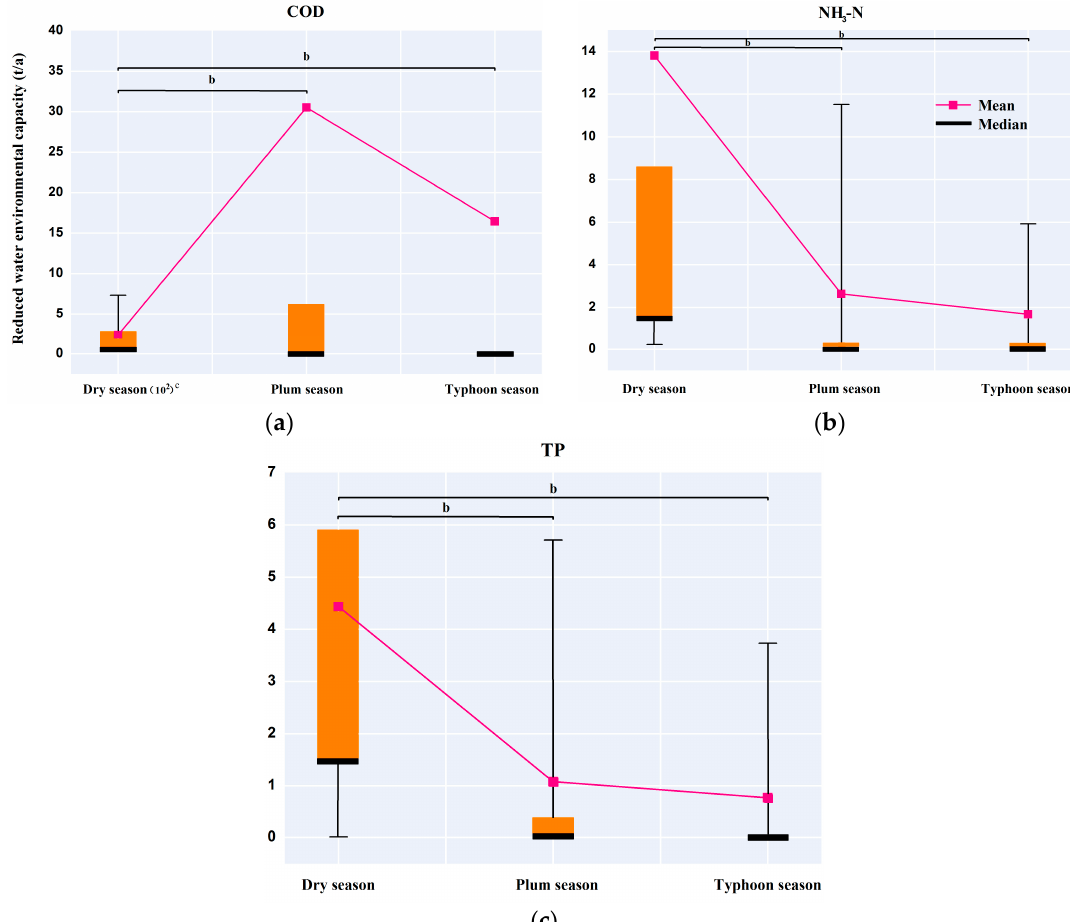
Figure 10. Difference in reduced WEC of pollutants among the three groups of seasons a : ( a ) the reduced group of COD; ( b ) the reduced group of NH 3 -N; and ( c ) the reduced group of TP. a The figure shows the significant difference in reduced WEC among three groups of seasons with the Mann–Whitney U test. The top and bottom of each box represent the first and third quartiles with the median as a horizontal line inside. Whiskers are drawn as the 10th or 90th percentiles of the distribution; b Significant difference between hydrological seasons ( p < 0.001 by the Mann–Whitney U test); c The unit of reduced WEC of COD in dry season: 10 2 t /a.